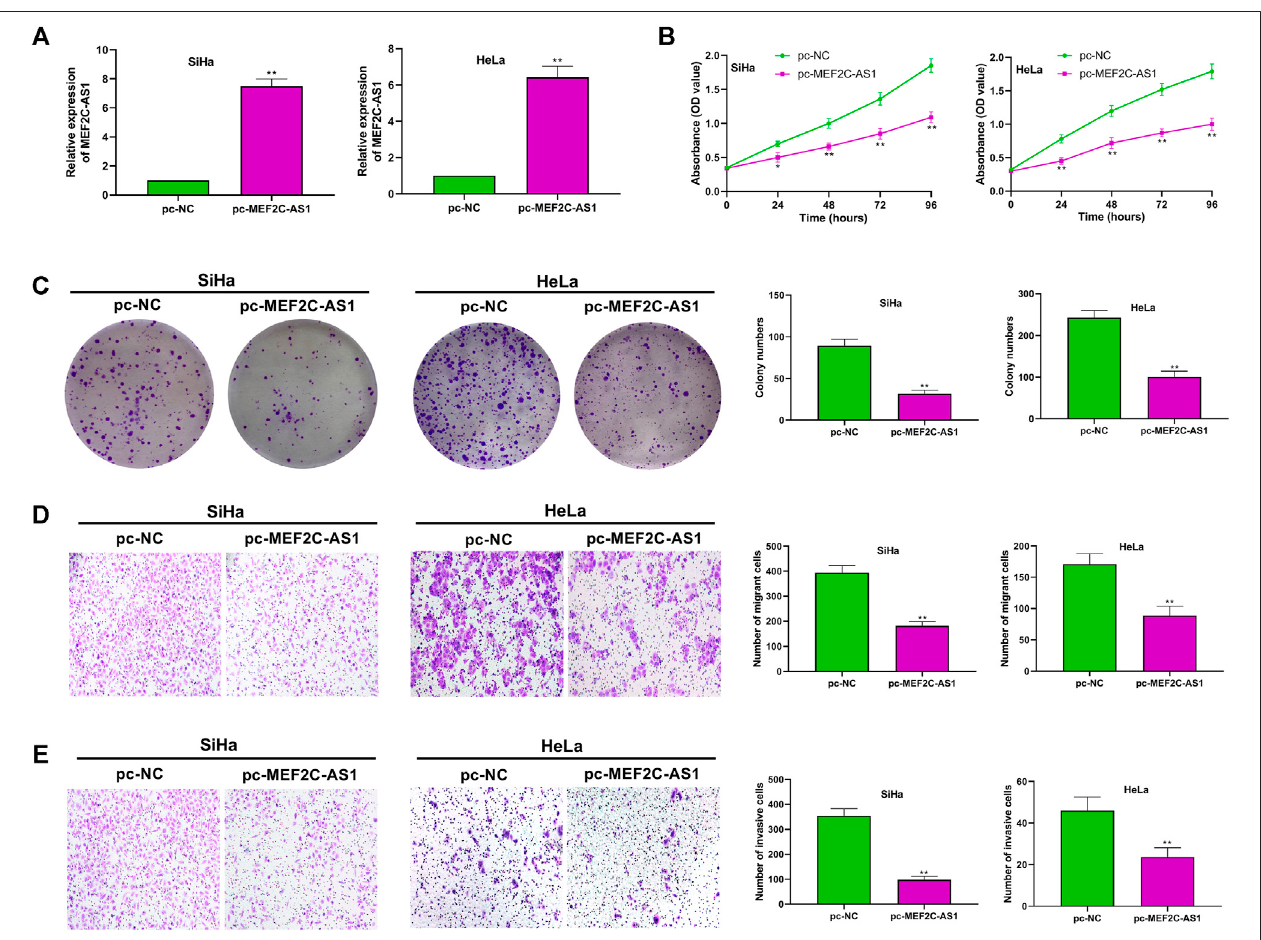
FIGURE 2 | Overexpression of lncRNA MEF2C-AS1 inhibited CC cell proliferation, migration and invasion. (A) The expression ef fi ciency of lncRNA MEF2C-AS1 was detected by qRT-PCR; (B) After transfection with pc-MEF2C-AS1, the proliferation ability of the SiHa and HeLa cells were measured by CCK-8; (C) After transfectionwithpc-MEF2C-AS1,thecolonyformationabilityofSiHaandHeLawasmeasured bycolonyformationassay; (D) Transwellassaywasconductedtodetect the migration ability of SiHa and HeLa; (E) The invasion ability of SiHa and HeLa was measured by Transwellassay. Measurementdata were expressed as mean ± standard deviation. The cell experiment is repeated three times independently. * p < 0.05, ** p < 0.01, compared with pc-NC group (A – E)